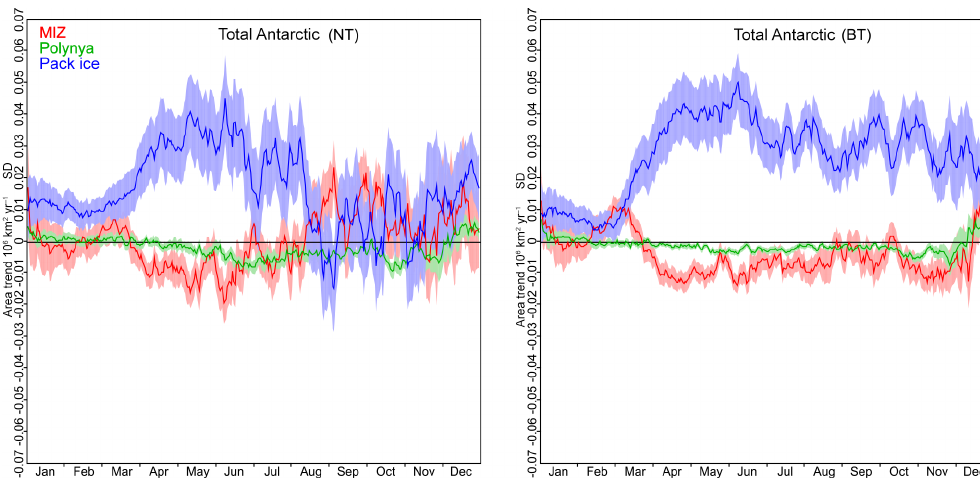
Figure 8. Daily trends (1979 to 2013) in the consolidated pack ice, the outer MIZ and potential coastal polynyas for the entire Antarctic sea ice cover for the NASA Team (left) and Bootstrap (right) algorithms. Trends are provided in 10 6 km 2 yr − 1 .